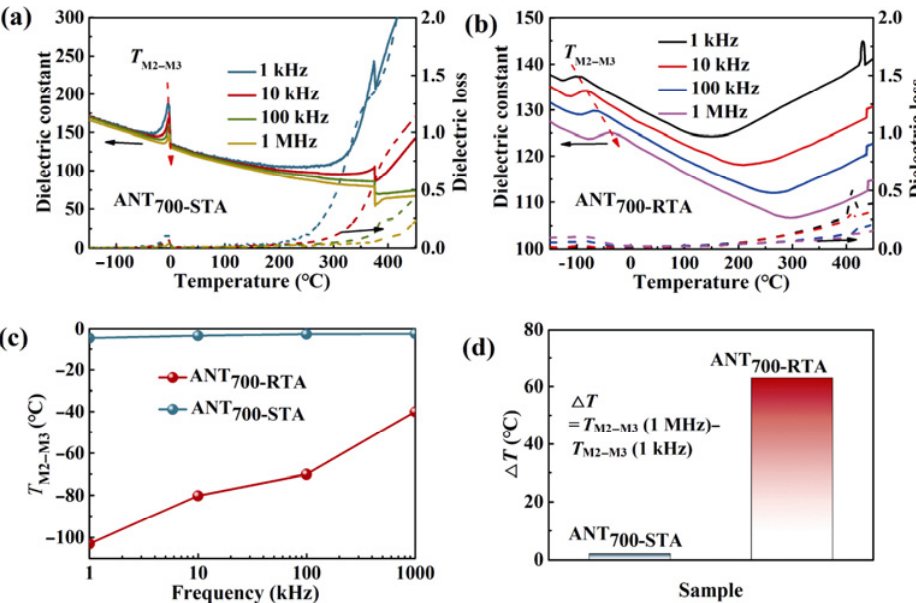
Fig. 5 Temperature-dependent dielectric constants and dielectric losses for (a) ANT 700-STA and (b) ANT 700-RTA films measured at different frequencies and (c) their corresponding T M2–M3 under different measuring frequencies (from 1 kHz to 1 MHz). (d) Frequency dispersion parameters ( ∆ T ) of ANT 700-STA and ANT 700-RTA films.